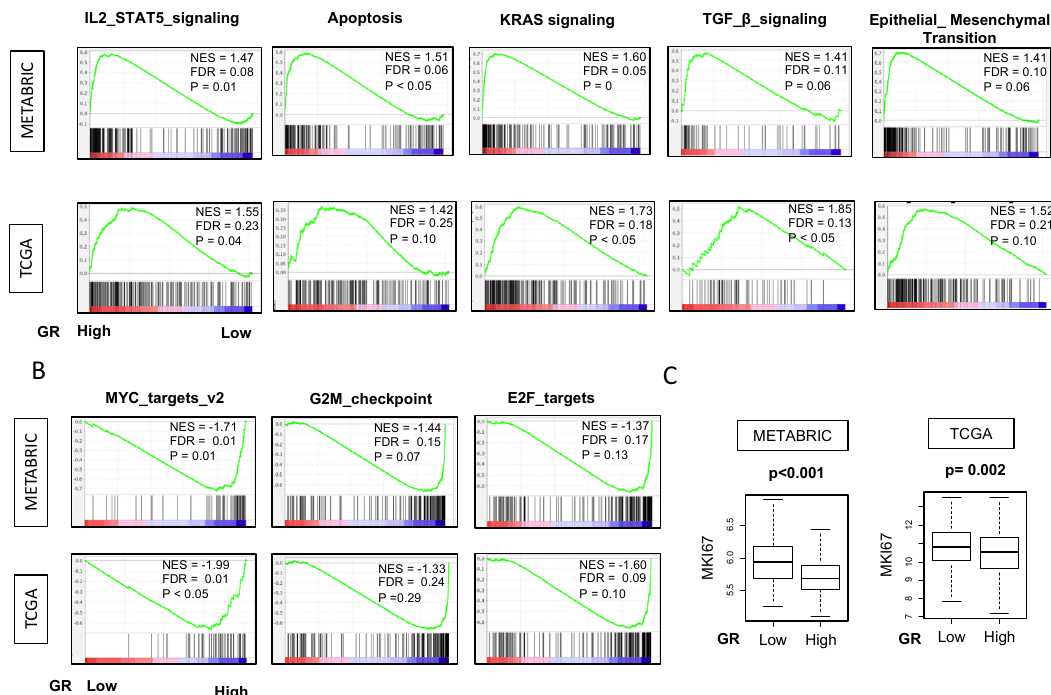
Figure 6. Hallmark gene sets with significant enrichment in GR high and low breast cancer in both METABRIC and TCGA cohorts. Gene set enrichment (GSEA) plots along with normalized enrichment score (NES) and false discovery rate (FDR) are shown for the gene sets for which enrichment was seen in ( A ) GR high and ( B ) GR low tumors in both METABRIC and TCGA in the entire cohort. NES and FDR were determined with the classical GSEA method. The cut-off of highest and lowest quartiles (25%) of NR3C1 expression was considered as GR high and GR low. The statistical significance of GSEA was determined using FDR of 0.25. Nominal p -value estimates the significance of the observed enrichment score for a single gene set. However, FDR is the estimated probability that a gene set within a given enrichment score (normalized for gene set size) represents a false positive finding as recommended by Broad Institute. ( C ) GR low tumors were associated with high MKI67 transcriptome analysis in both METABRIC and TCGA in the entire cohort. Depicted p values are calculated using one-way ANOVA.